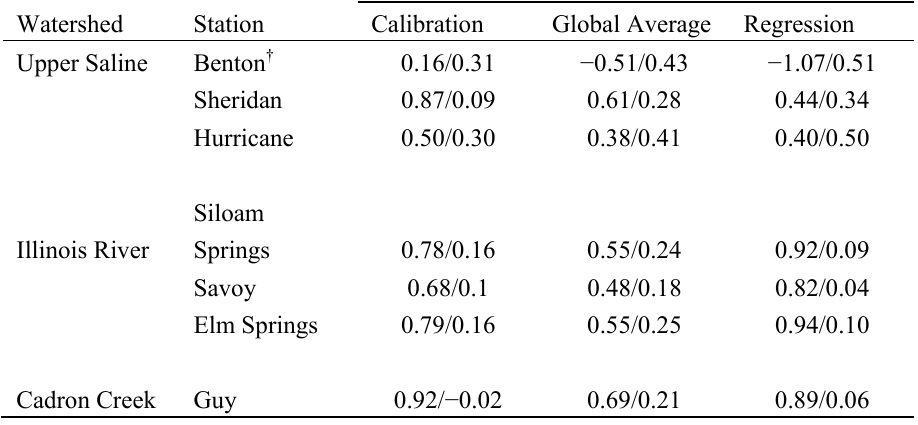
Table 6. Annual NS and Dv values for the period October 1998 to September